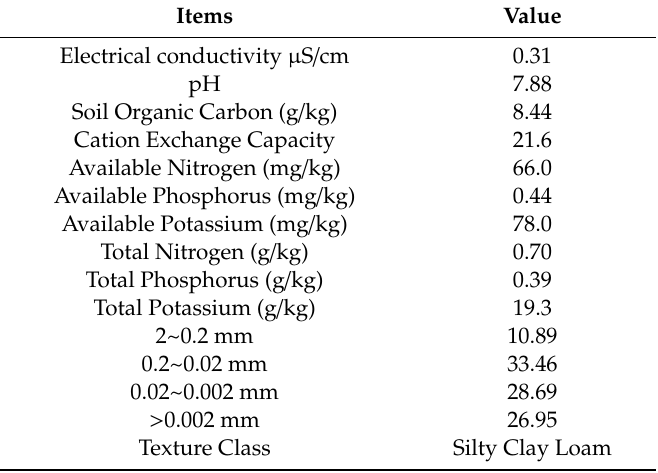
Table 2. Physicochemical properties of soil used in the